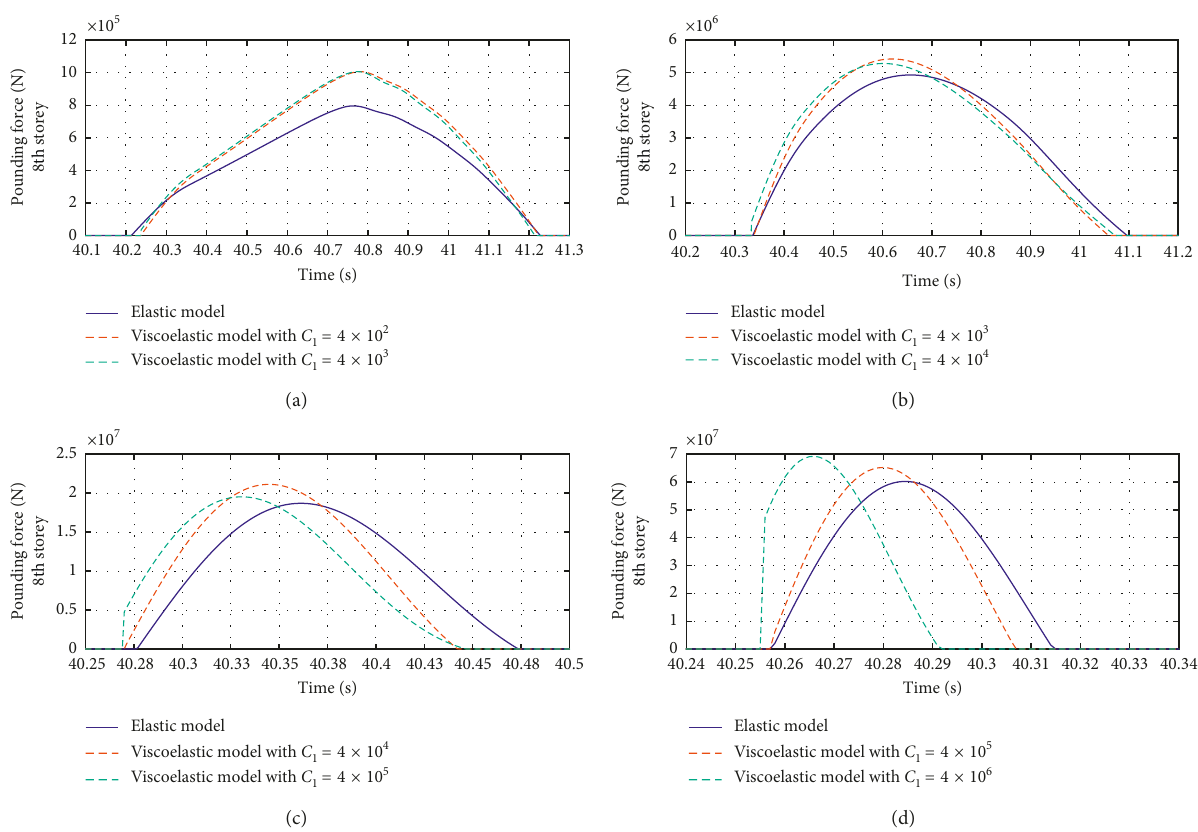
Figure 10: Pounding force with different gaps between buildings: (a, e, i) d � 0.04m; (b, f, j) d � 0.05m; (c, g, k) d � 0.06m; (d, h, l) d �